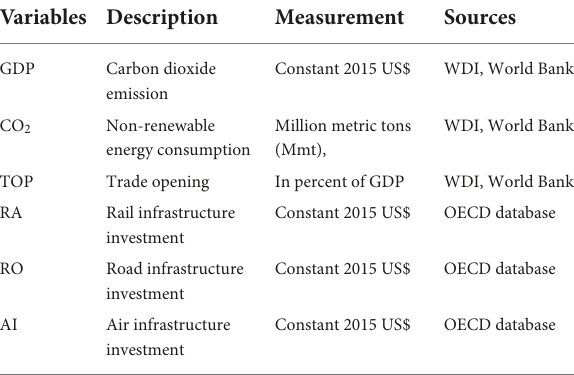
TABLE 1 Variables description, measurement, and data